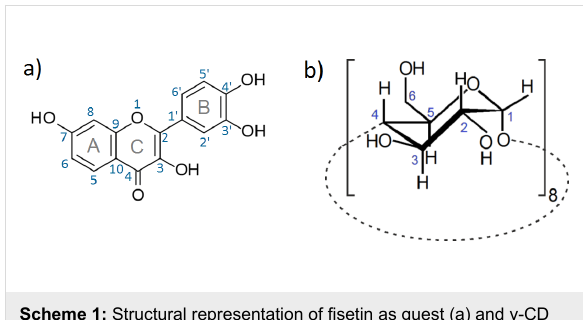
Scheme 1: Structural representation of fisetin as guest (a) and γ -CD as host (b) used in the present study, depicting the herein adopted labeling for atoms and rings of